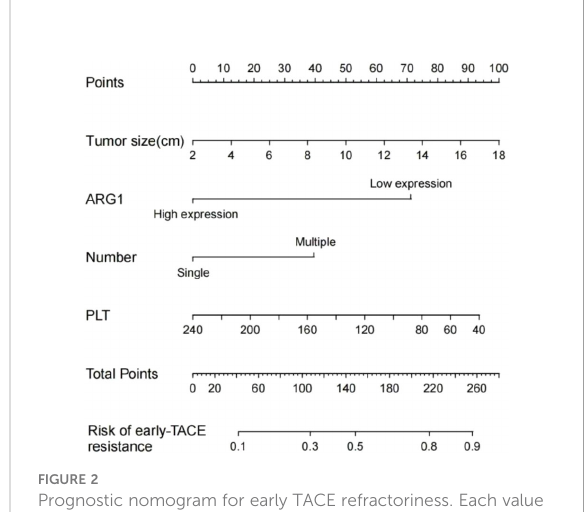
(Figure 2). The CT image results from March 2020 are shown in Figure 4A; two TACE treatments were performed in March and May 2020. In August 2020, the patient developed a portal vein tumor thrombus (Figure 4B), which indicated disease progression. Furthermore, disease progression occurred 5